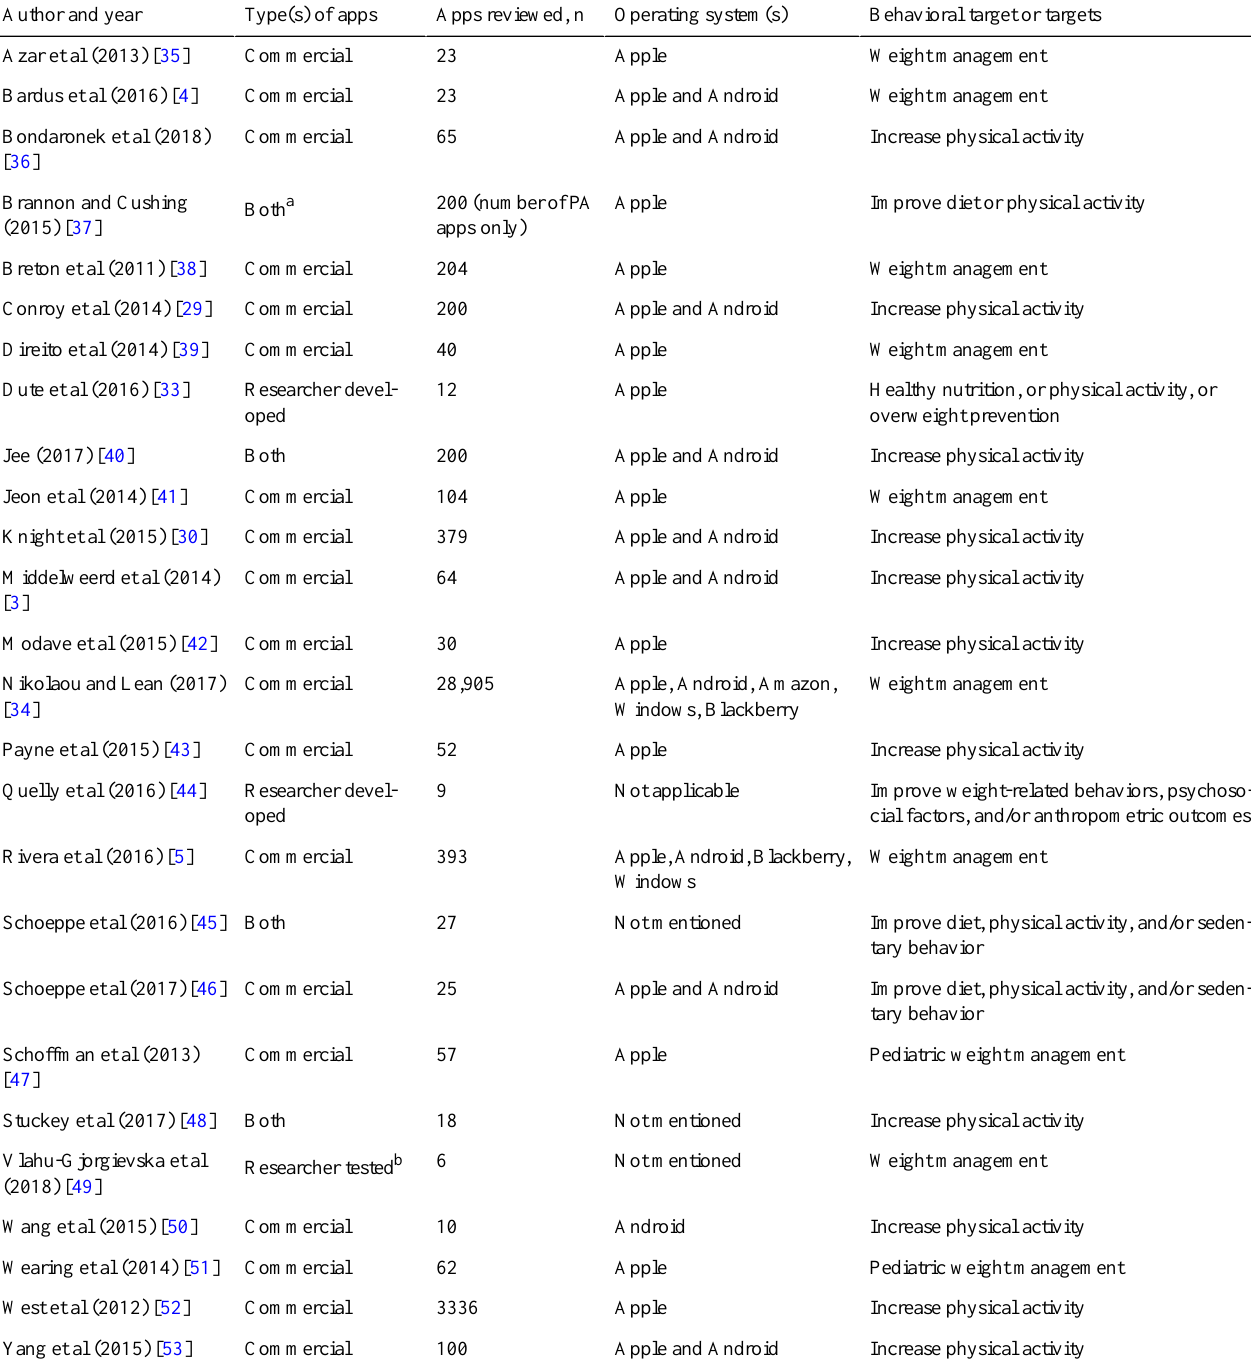
Table 1. Descriptive information for each included review of physical activity and related